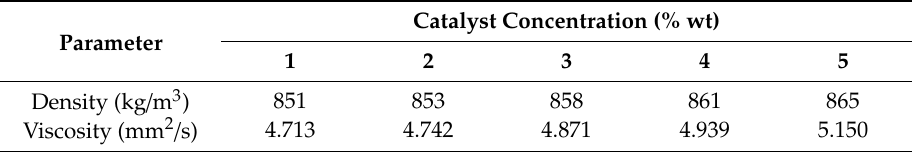
Table 7. Biodiesel density and viscosity at various catalyst concentrations.